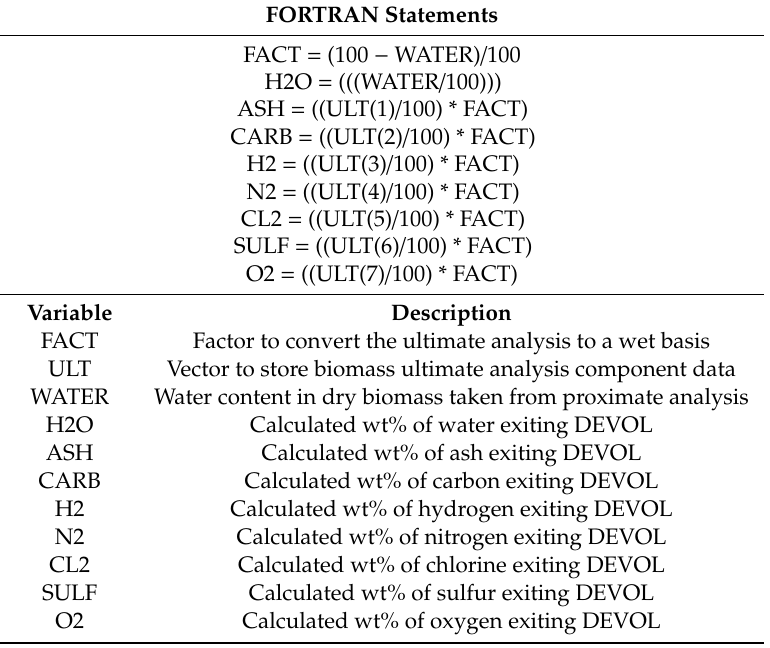
Table A2. FORTRAN statements for devolatilization yields (DECOMP Calculator